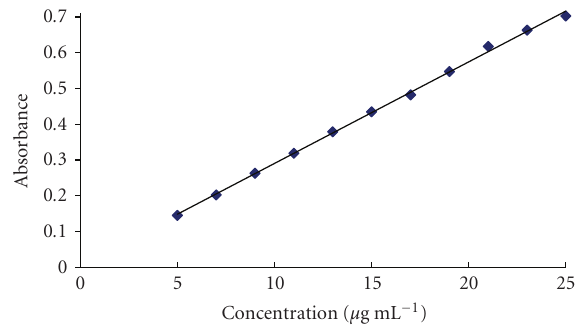
Figure 8: Calibration plot of absorbance versus the concentration of cefotaxime at preselected fixed time of 3